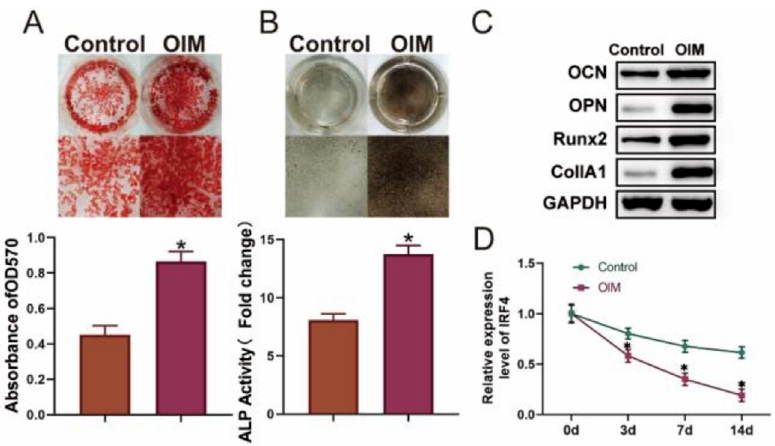
Fig. 1. IRF4 is lowly expressed during osteogenic differentia- tion. ARS (A) and ALP (B) staining assays were applied to eval- uate osteogenic differentiation. Western blotting was performed to detect the biomarkers of osteogenic differentia- tion (C), and q-PCR assay was used to examine IRF4 expression (D). * p < 0.05. Data represent at least three independent sets of experiments.